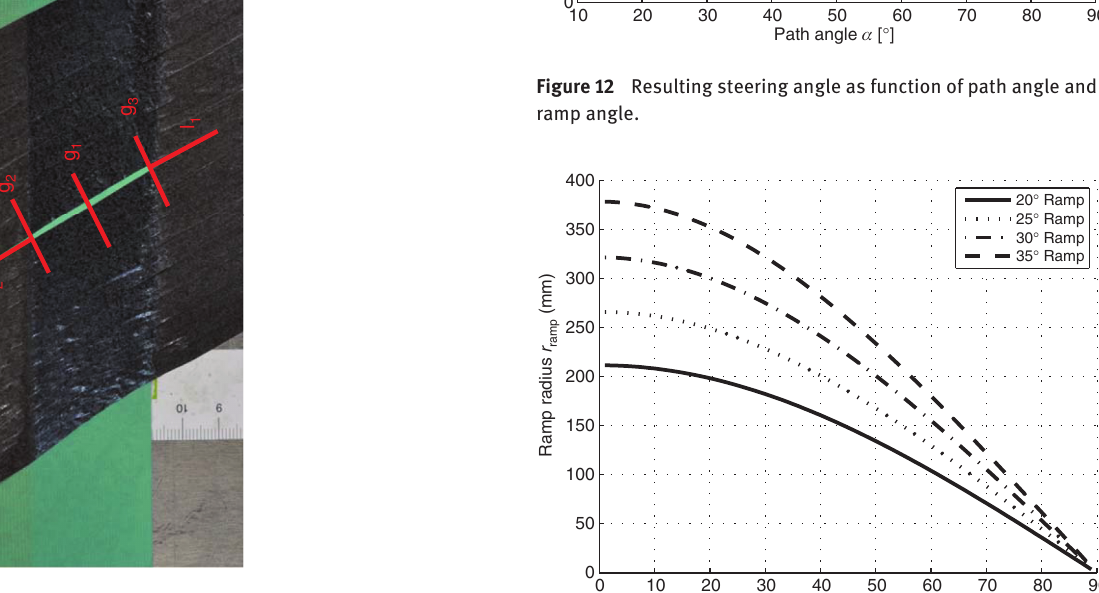
Figure 10 Evaluated results of the experimental testing of gaps.